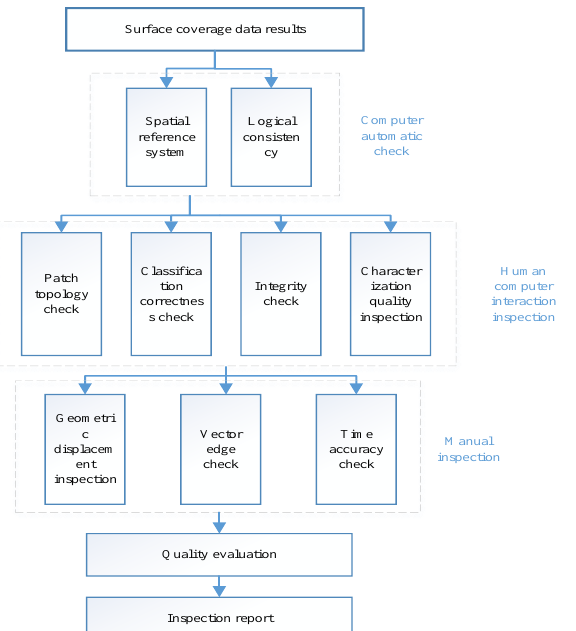
Figure 1. Technical flow chart of surface coverage data result quality inspection